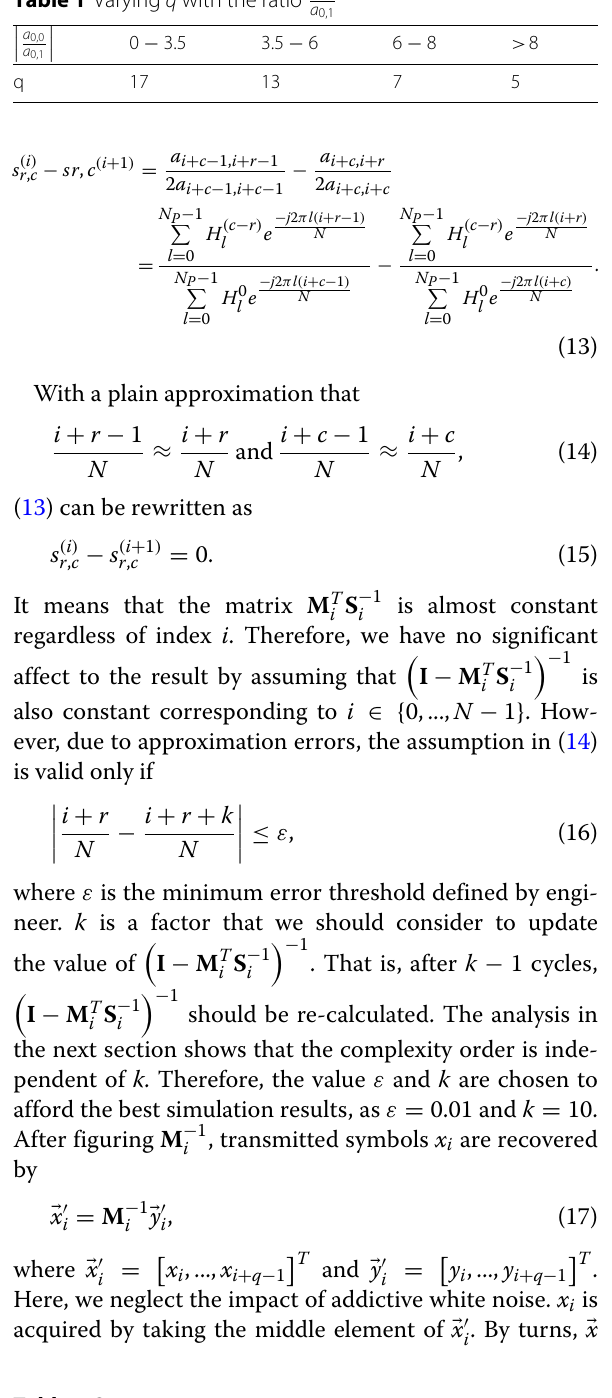
Table 1 Varying q with the ratio a 0,0